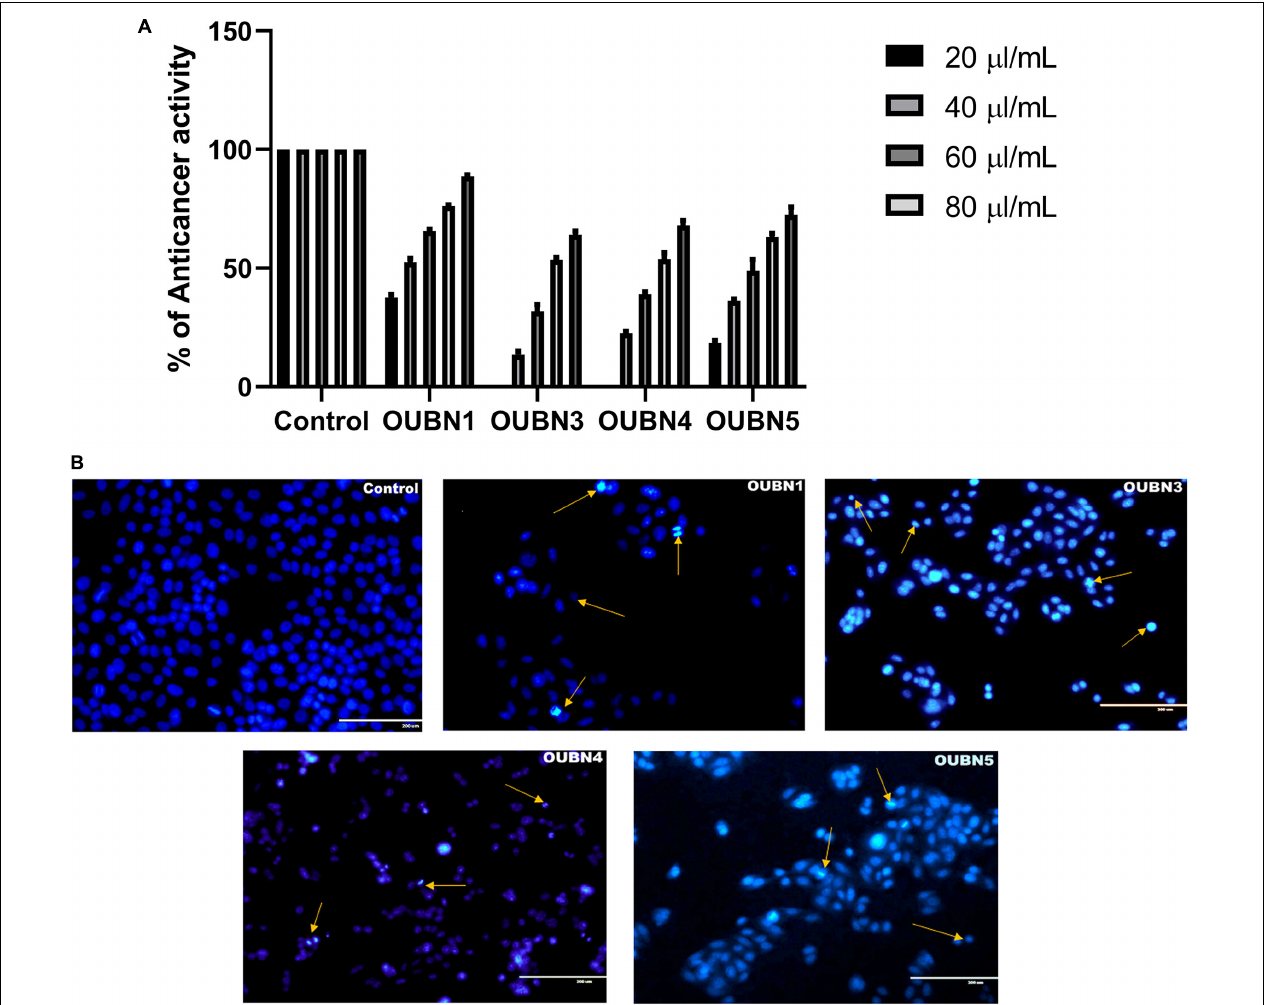
FIGURE 5 | (A) Anticancer activity determined by MTT [-(4, 5-Dimethylthiazol-2-yl)-2, 5-diphenyltetrazolium bromide] assay. Experiments were done by using CFS of 20, 40, 60, 80, 100 µ l/ml concentrations from CFS of OUBN1, OUBN3, OUBN4, and OUBN5, respectively. Data shown are triplicate values of mean ± SD of independent experiments. (B) Apoptosis determined for untreated and treated HT-29 cells with OUBN1, OUBN3, OUBN4, OUBN5 isolates by DAPI (4, 6-diamidino-2-phenylindole) staining. Scale 200 µ